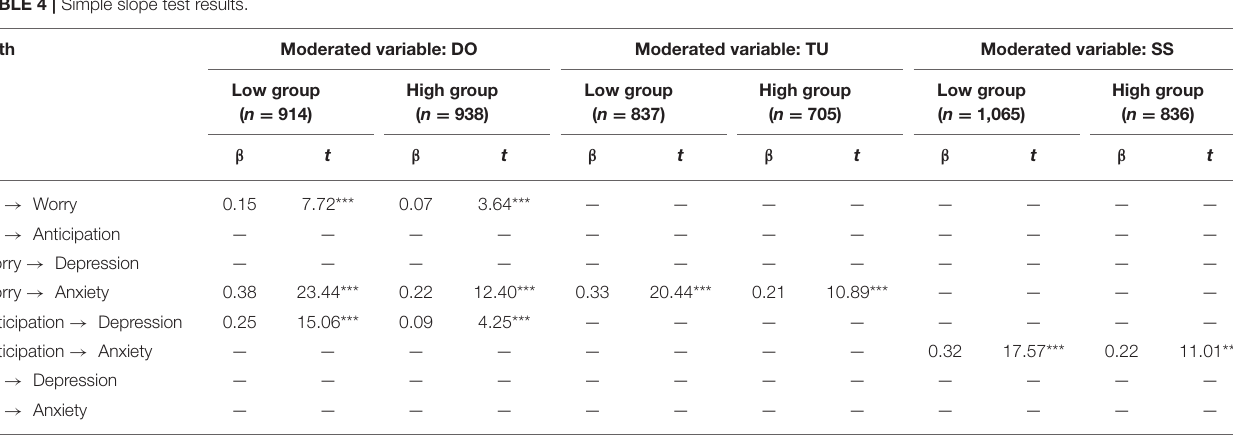
Low group means those whose scores lower than M – 1 SD, while high group means those whose scores higher than M + 1SD. *** p < 0.001 , ** p < 0.01